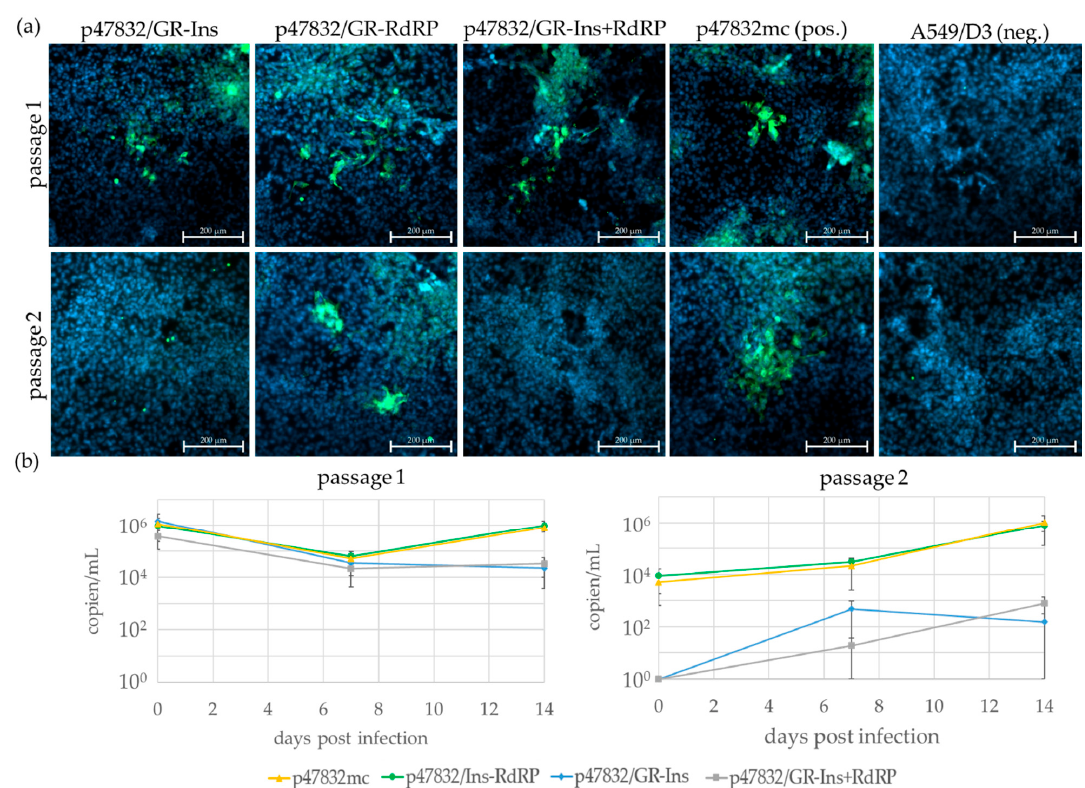
Figure 4. Testing of constructs containing glycine-to-arginine substitutions corresponding to the described G1634R mutation in the RdRp region and/or in the insertion region of the HVR of strain 47832c. The indicated constructs were transfected into BSR T7/5 cells and the resulting cell lysate was used for passaging on A549/D3 cells. The A549/D3 cells from the first (passage 1) and second (passage 2) passage are shown. ( a ) Immunofluorescence analysis of cells using an HEV capsid protein-specific antiserum. Green signal: HEV capsid protein, blue signal: nuclear DAPI staining. Scale bar: 200 µm. ( b ) RT-qPCR analysis of HEV genomes present in cell culture supernatants. Data are means +/ − SD from two independent experiments.